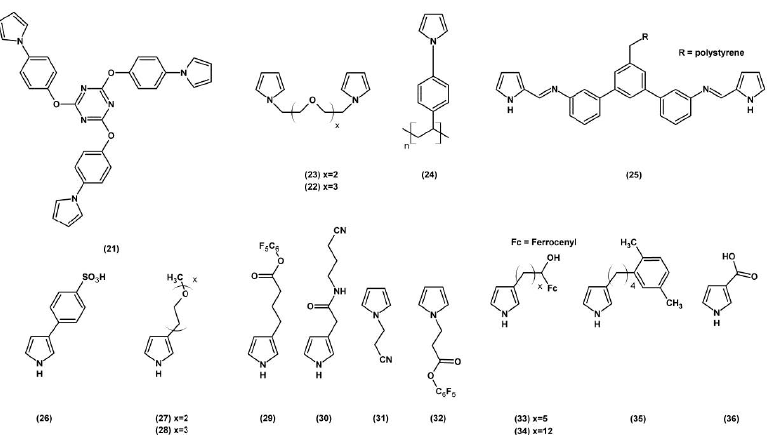
Figure 2. Chemical structures of pyrrole derivatives 21 – 36 used as co-monomers for electrochemi- cal polymerisation.